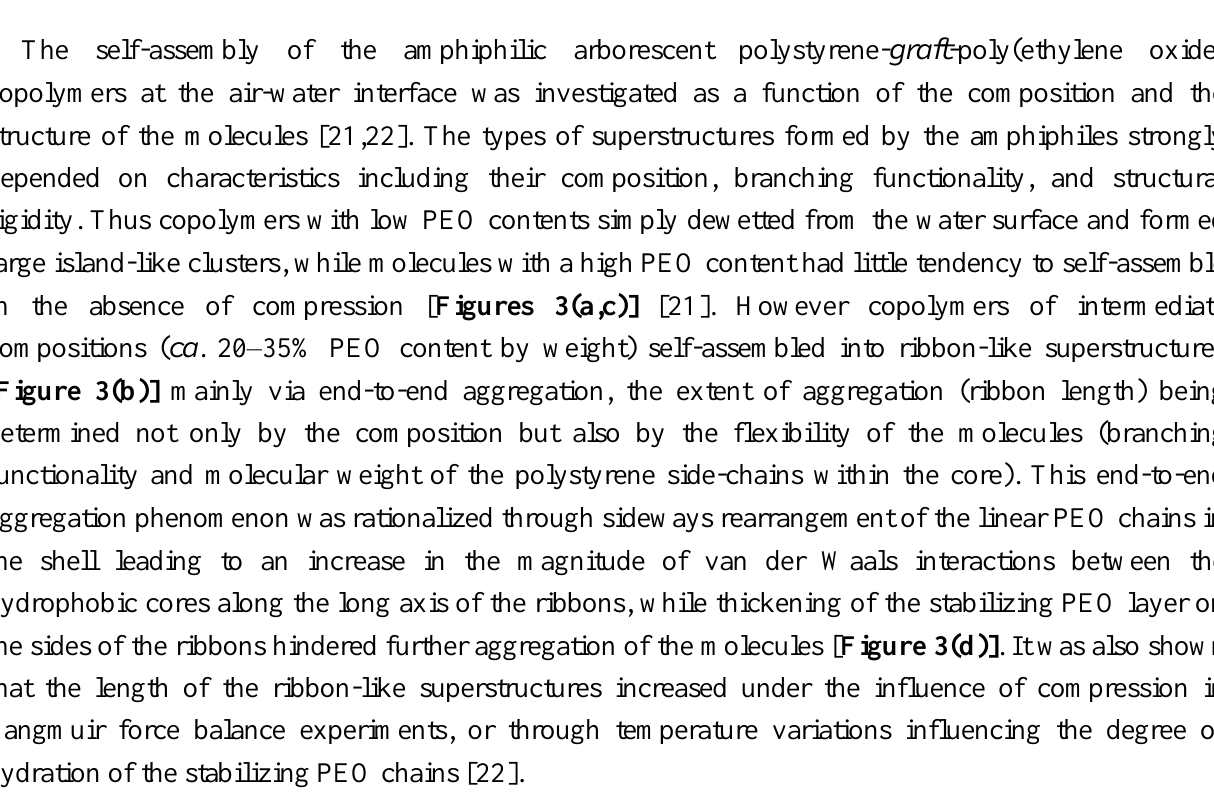
Figure 3. Self-assembly of arborescent polystyrene- graft -poly(ethylene oxide) copolymer molecules at the air-water interface without compression: (a) low branching functionality, low PEO content G1-30PS-LB-15, (b) low branching functionality, intermediate PEO content G1-30PS-LB-31, and (c) high branching functionality, high PEO content G1-30PS-HB-43. Each picture has a width of 1.5  m. (d) End-to-end